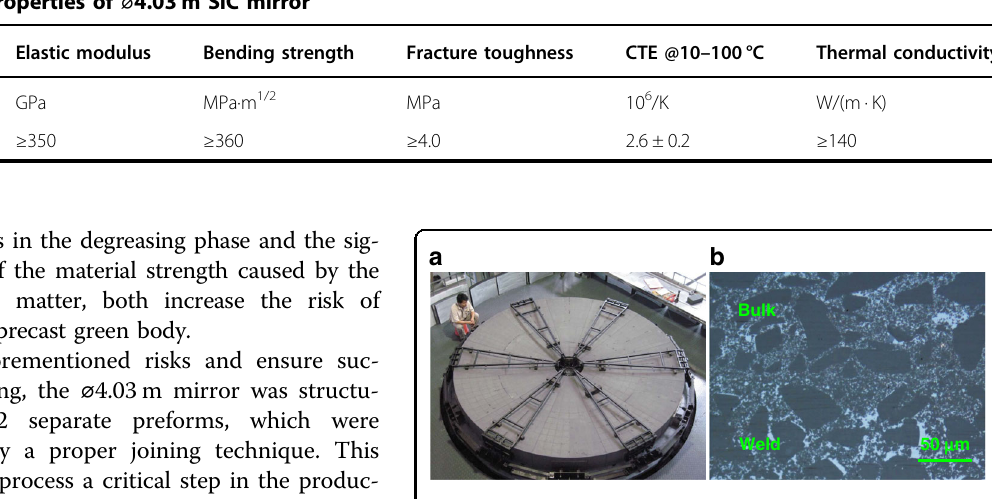
Fig. 4 Parts joining and sintering results of ⌀ 4.03 m SiC blank. a Green body parts joining, b the microstructure photo after